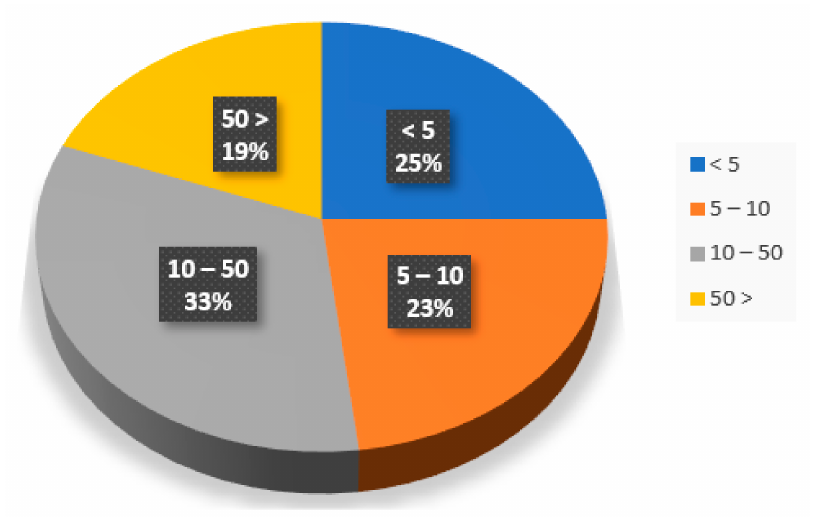
Figure 3. Citation distribution of ML-based resource estimation papers in this review.